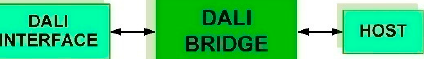
Figure 1. Schematic block diagram of the Digital Addressable Lighting Interface (DALI) Bridge connection.